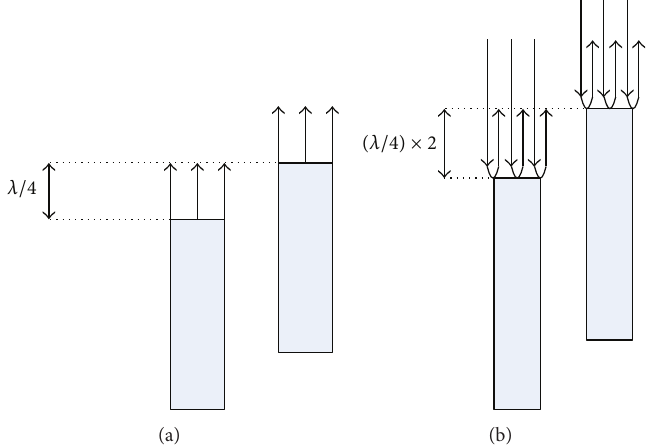
Figure 1: The path of scattering and radiating wave with ladder arranged array.